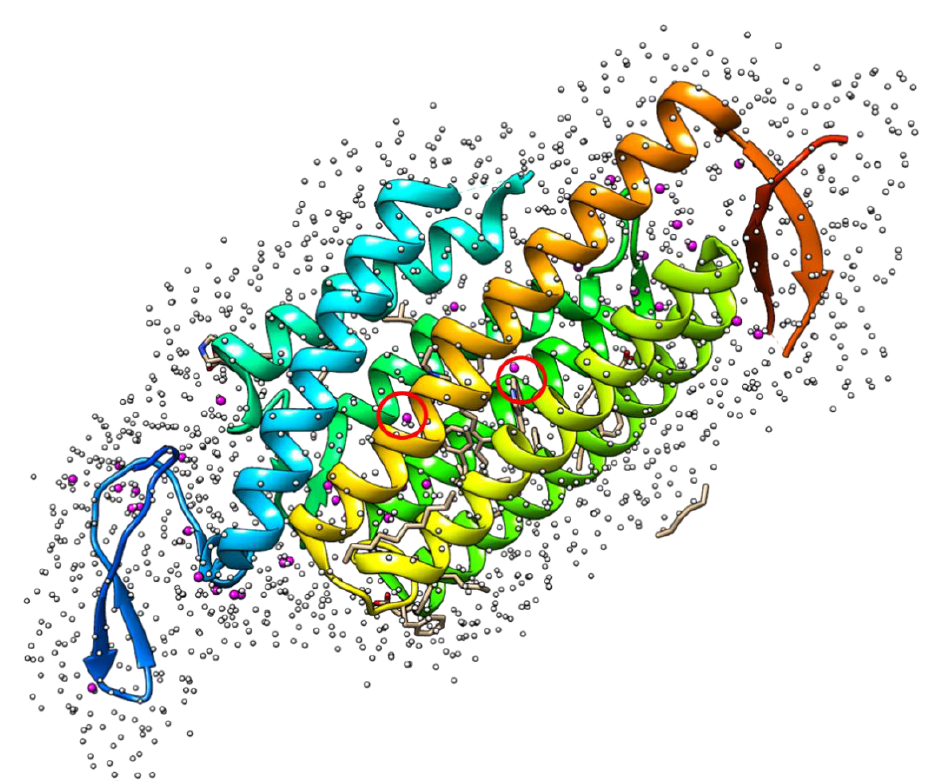
Figure 3. Distribution of water oxygen atoms from 3D-RISM-KH calculations on protein 3UG9 (white spheres). The crystallographic waters are represented with magenta spheres. The catalytic binding site waters were marked in red circle.